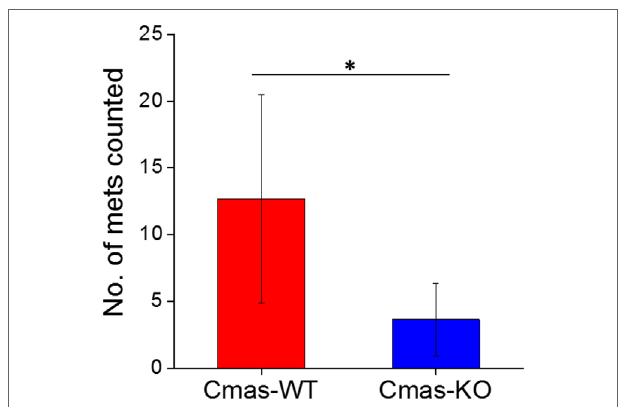
FigUre 9 | Orthotopically injected Cmas -KO cells form fewer discrete lung metastases compared to Cmas -wild type (WT). Each data point is the total number of discrete metastatic lesions counted over six sections, taken at 200 µm depth intervals, of the same lung. Values are the average of six ( Cmas -WT) or eight ( Cmas -KO) biological replicates, and error bars represent SD. The asterisk (*) denotes statistical significance of difference ( p -value <